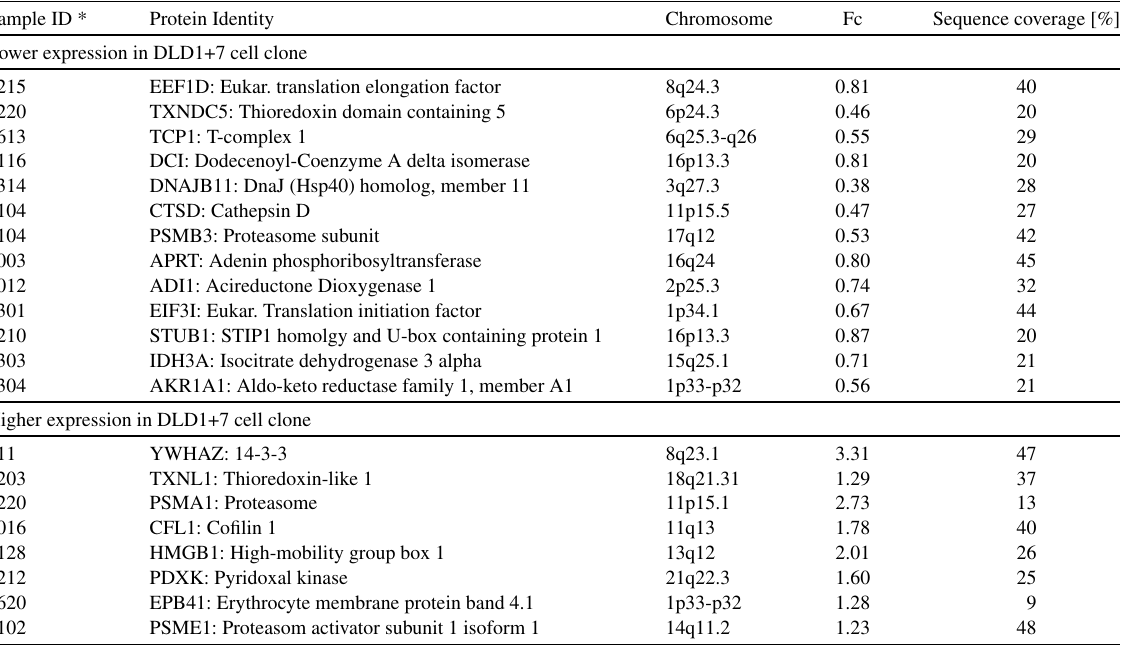
Identifications of the DLD1 versus DLD1+7